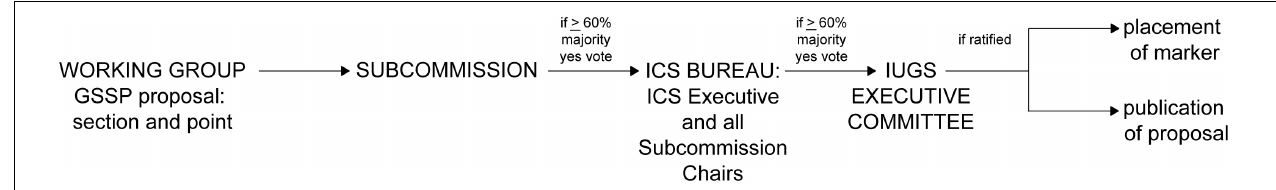
Frontiers in Earth Science |